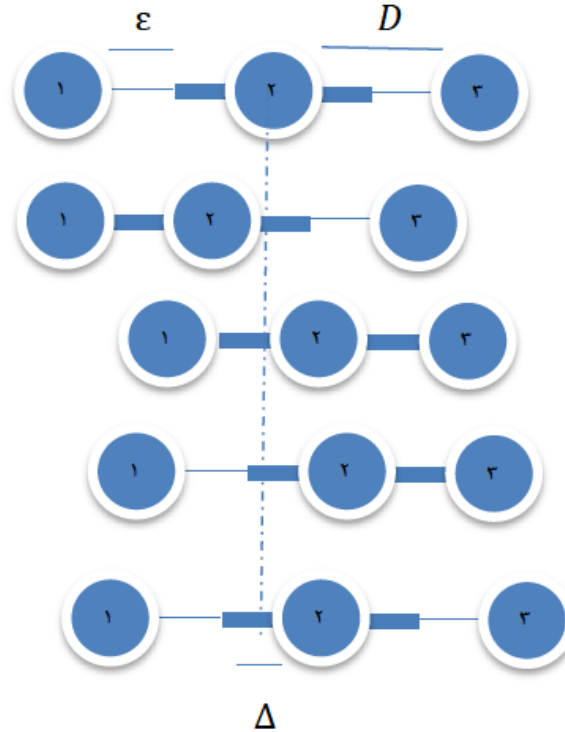
Figure 1: Three-dimensional model for nanobot